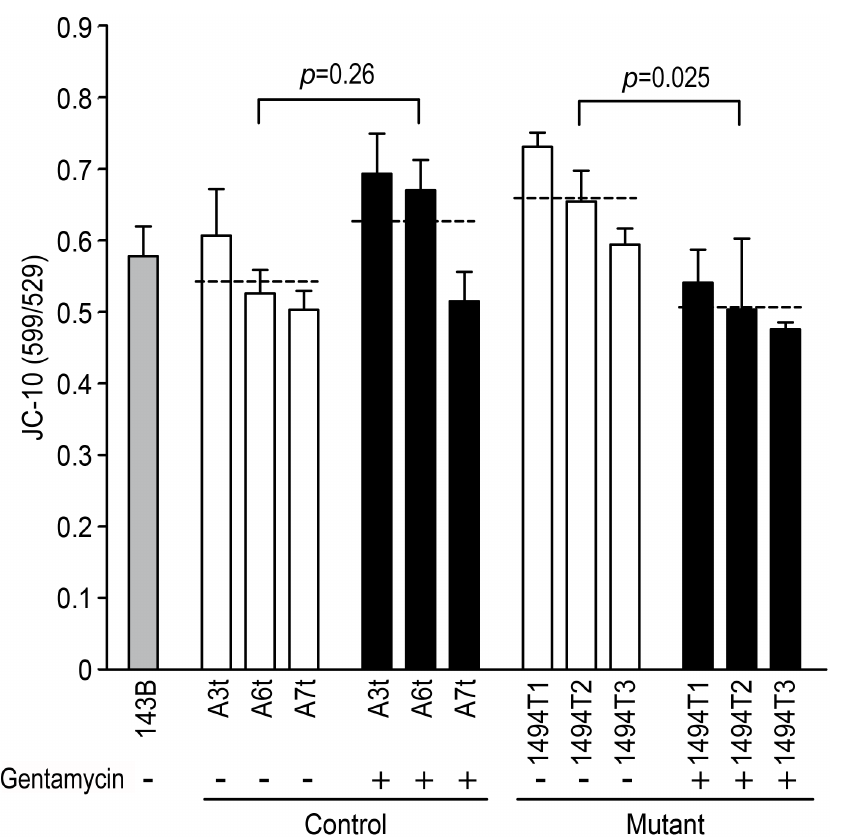
Figure 3. Measurements of the mitochondrial membrane potential. The mitochondrial membrane potential ( Dy m ) was measured via the JC-10 assay. The ratio of the Ex/Em 5 488/590 nm and 488/529 nm fluorescence intensities (FL590/FL529) was recorded to determine the Dy m level in each sample. The relative ratios of the FL590/FL529 geometric means between the mutant and control cell lines were calculated to reflect Dy m . The data are representative of three independent experiments; Students t -test, unpaired, two-